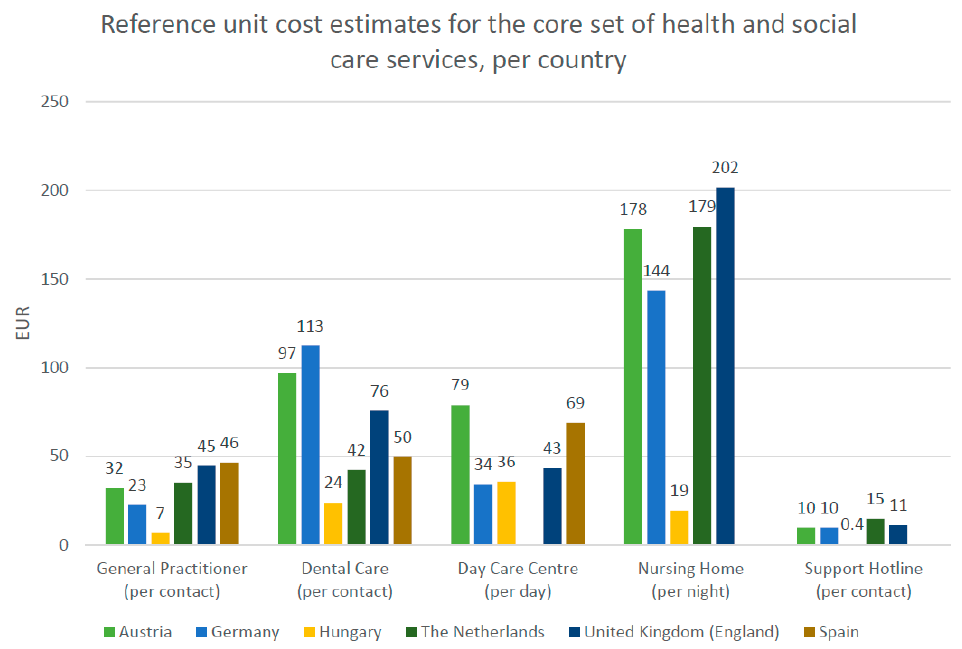
Figure 1. PECUNIA RUC estimates compatible with the PECUNIA RUM instrument per selected health and social care service for each PECUNIA partner country (in Euro, for year 2019; n = 27). Note: The figure presents the 27 RUCs that are suitable for valuation in combination with the PECUNIA RUM instrument.